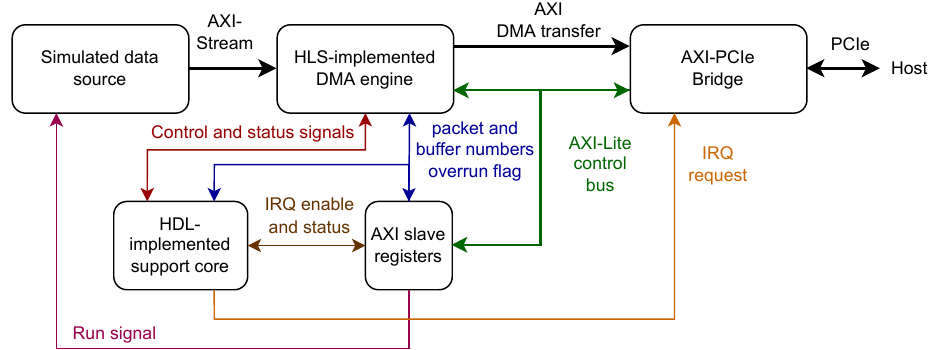
Figure 12. Block diagram of the demo project testing the DMA engine with simulated data source in the actual